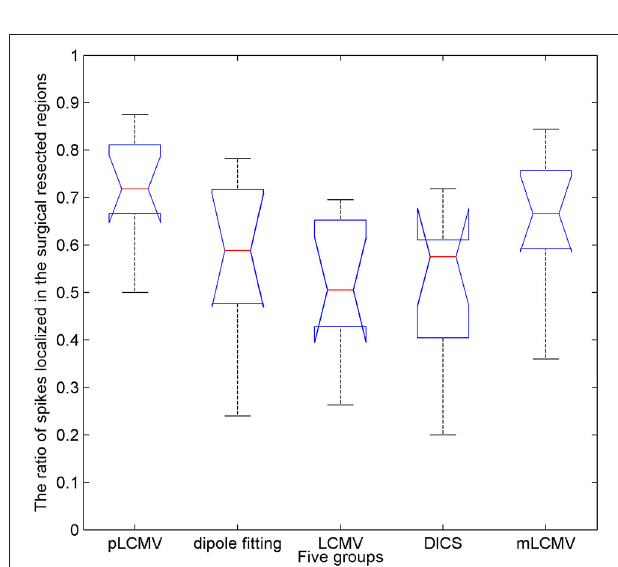
FIGURE 7 | Significance test of mean difference of the five groups of localization results using analysis of variance (ANOVA). The x-axis represents the five groups, and the y-axes represent the ratios of the number of spikes localized in the surgical resected region to the total number of spikes.